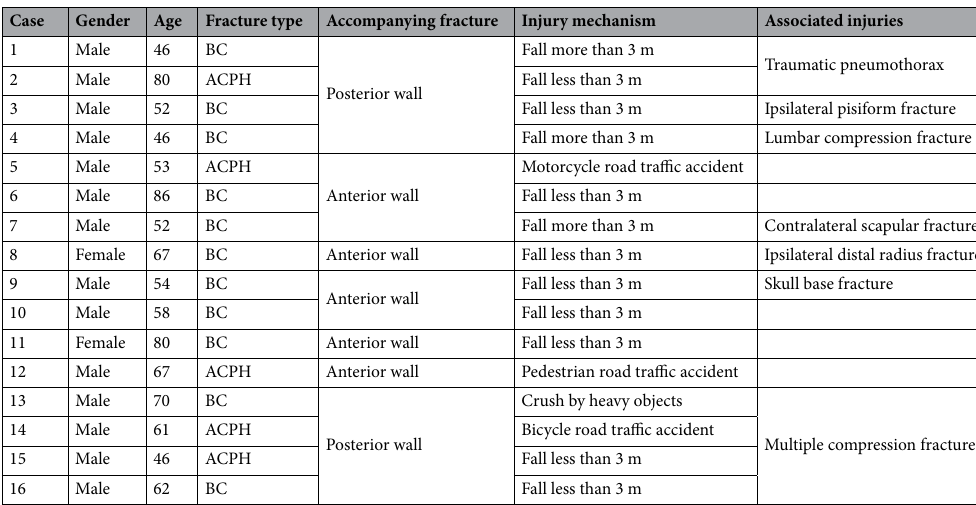
Table 1. Data for 16 patients using a quadrilateral surface plate through modified Stoppa approach. BC both column fracture, ACPH anterior column and posterior hemitransverse fracture.